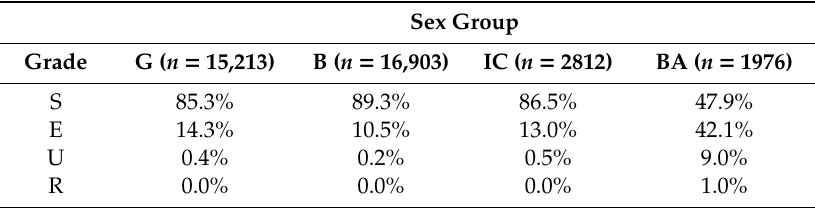
Table 3. Proportion of carcasses (%) within one grade according to the German grading system (SEUROP) for pig carcasses of gilts, boars, immunocastrates and barrows. Distributions vary significantly from each other ( p < 0.0001).